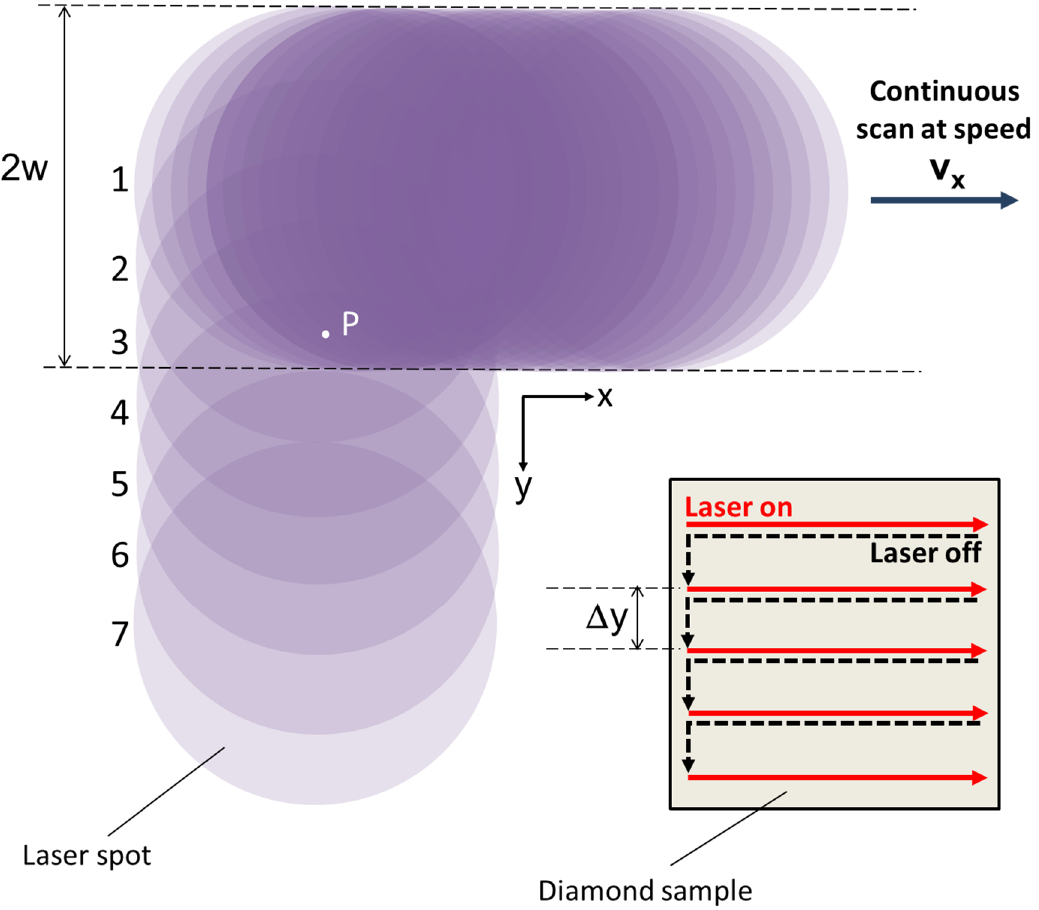
Figure 1. Laser scanning patterns used for the treatment of the diamond samples. The laser beam scans the sample (“laser on”) along x , than blanks (“laser off”), moves back to the starting point, shifts along y by a distance Δ y , switches on again, and starts a new scan along x . For the sake of clarity, only the first laser spot of horizontal scans #2 to #7 is shown. Note that the point P is subjected to five laser scans along x (rows 1 to 5), but it is not irradiated when the laser scans rows 6 and 7. The same value of total accumulated laser fluence was delivered to each of the treated samples.